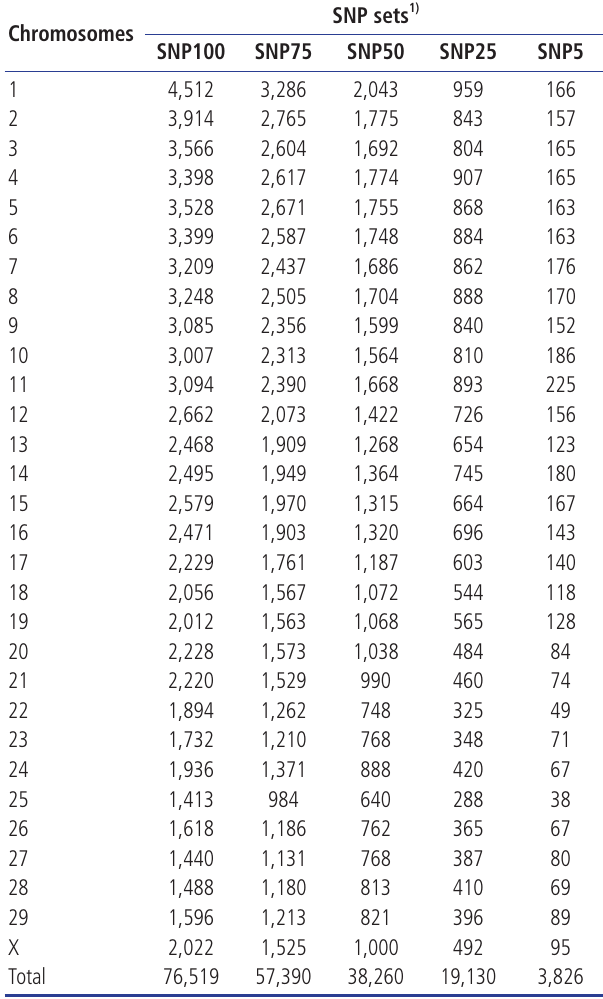
Table 1. Number of SNP per chromosome and total for the five SNP